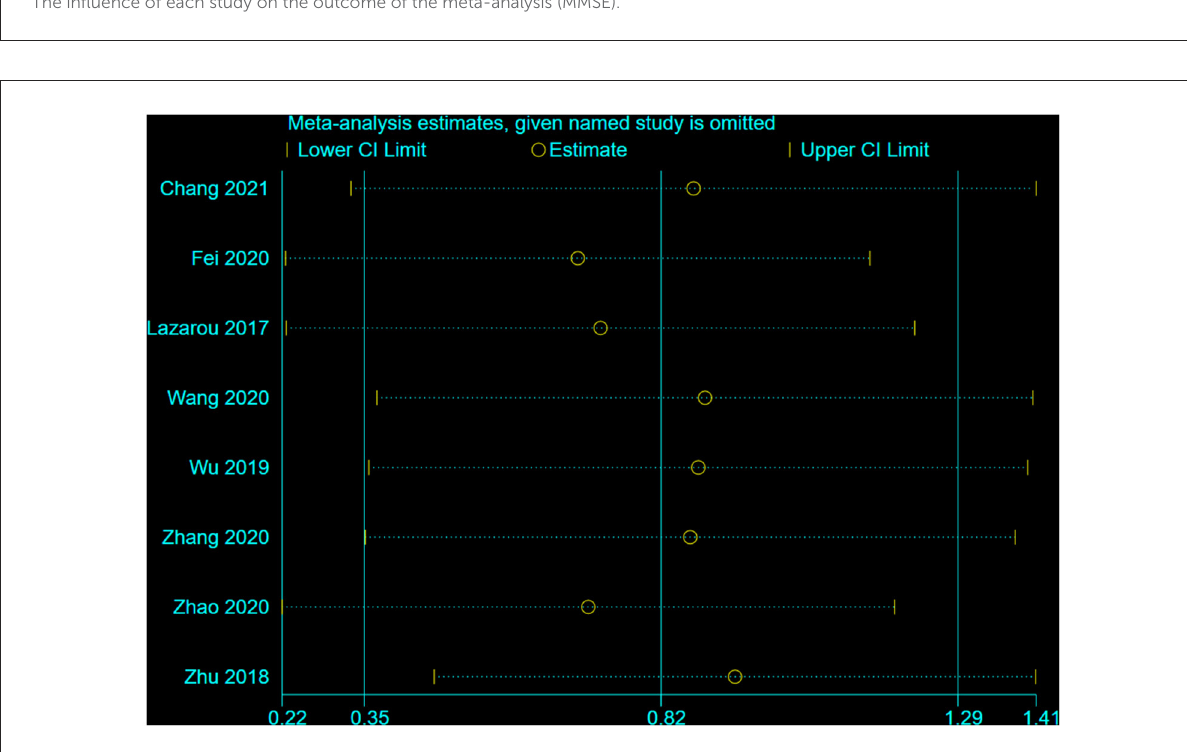
FIGURE10 The influence of each study on the outcome of the meta-analysis (MoCA).